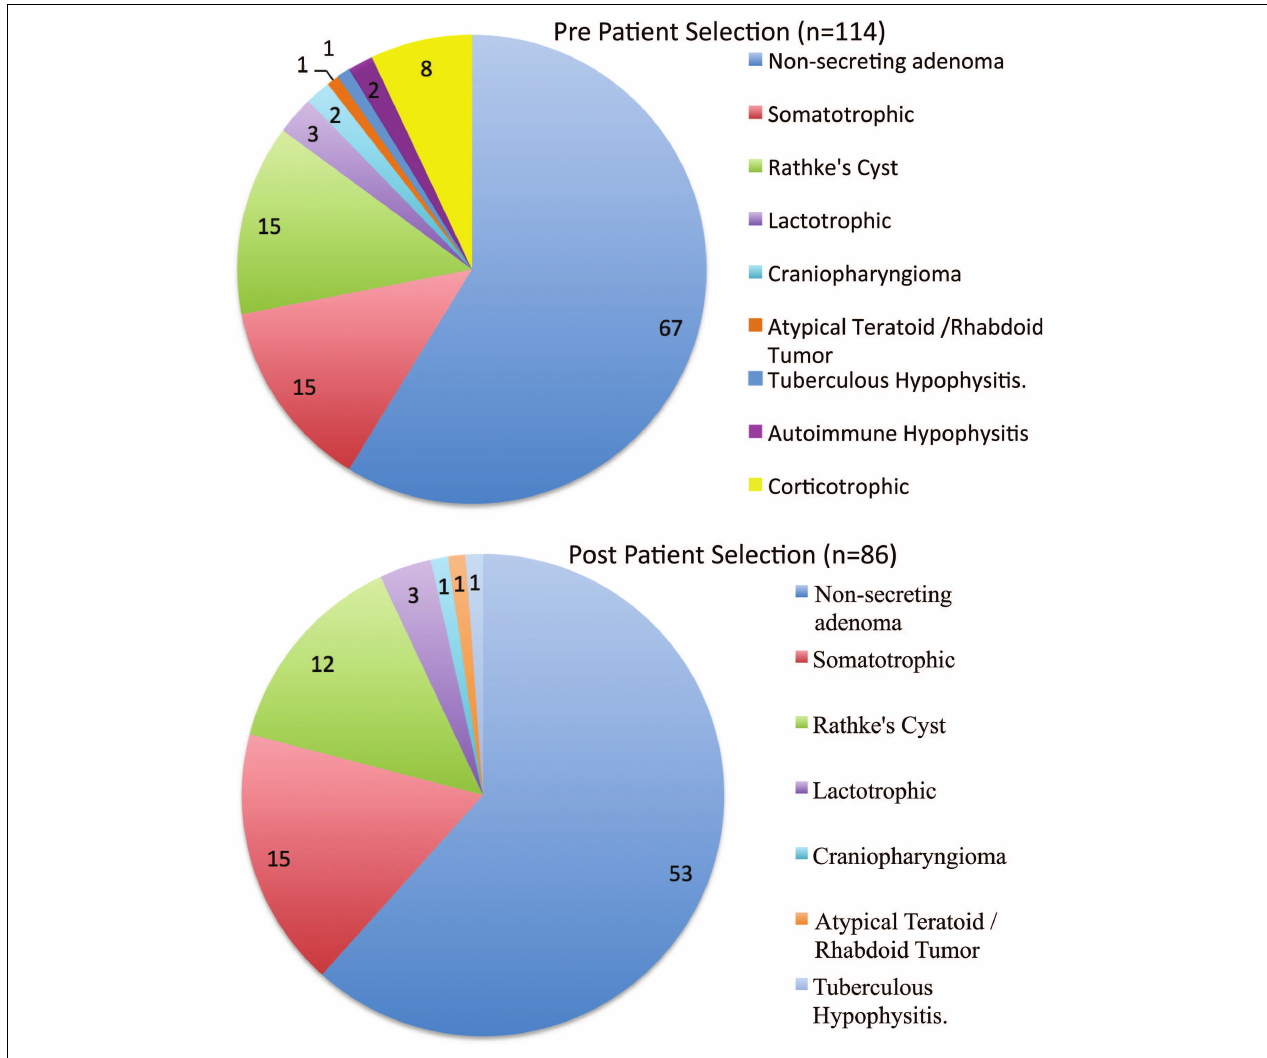
FIGURE 1 | Pre- and Post-patient selection tumor